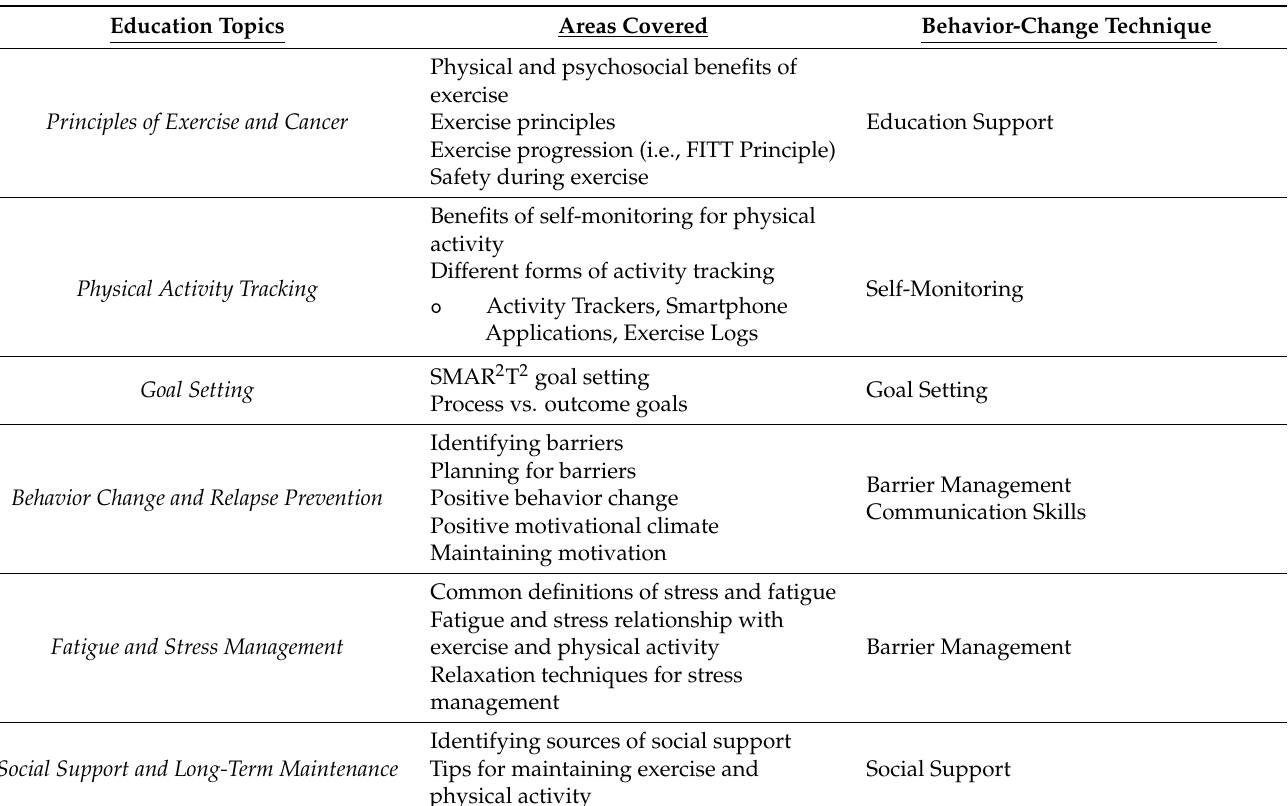
Table 2. “Exercise and Educate” Summary